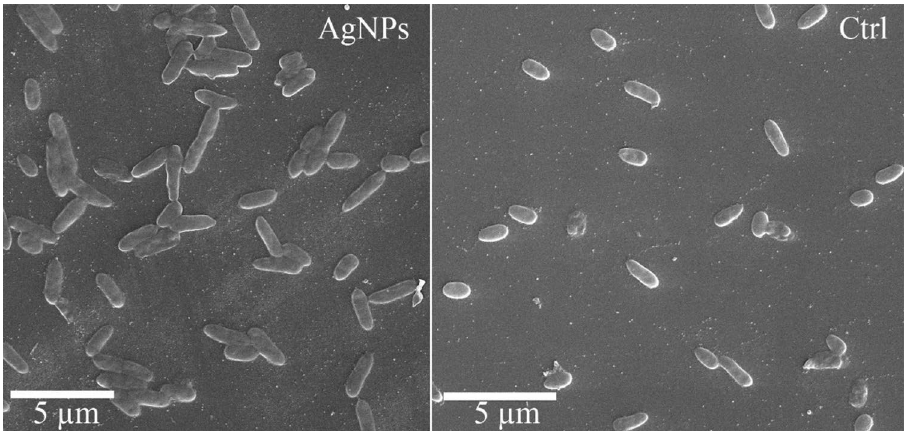
Figure 7. Scanning electron micrographs of Pseudomonas tolaasii Pt18 cells treated with AgNPs biosynthesized by Pseudomonas canadensis Ma1 strain. (Ctrl) non-treated control cells.